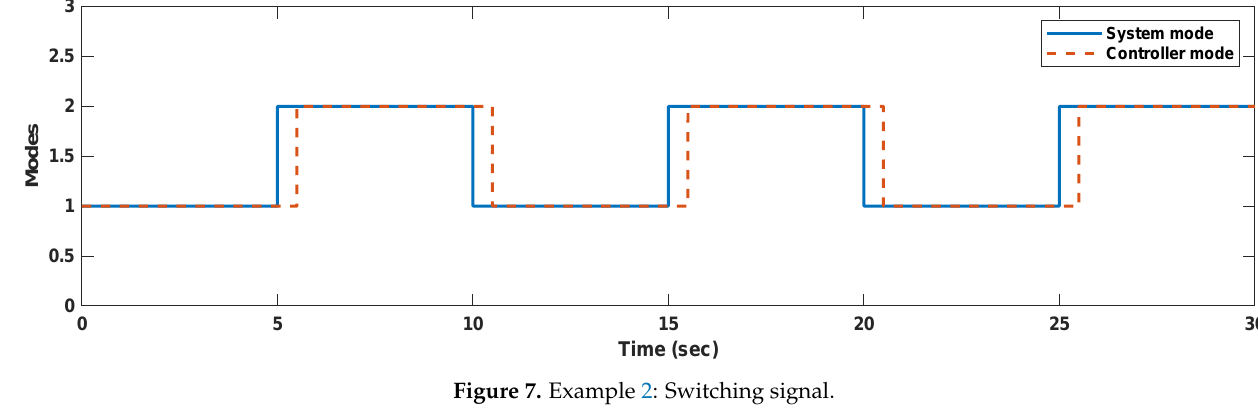
Figure 7. Example 2: Switching signal.